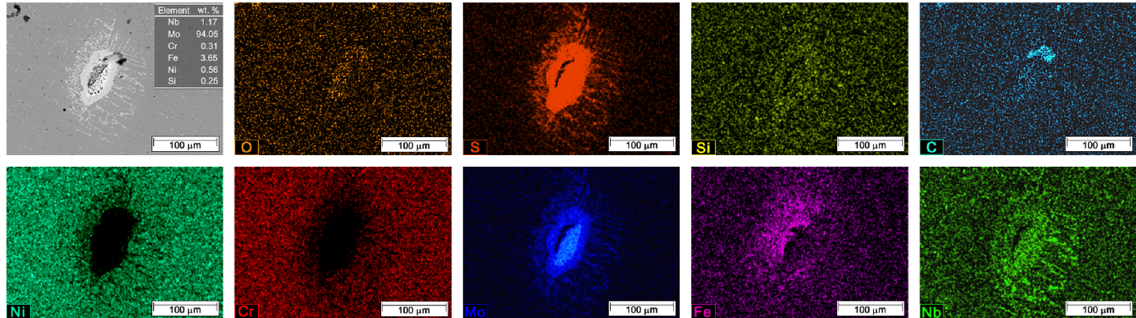
Figure 9. SEM micrograph and EDS chemical distribution mapping of Mo, S, Nb, Si, Ni, Cr and Fe elements for the inclusion particle located at WM region.